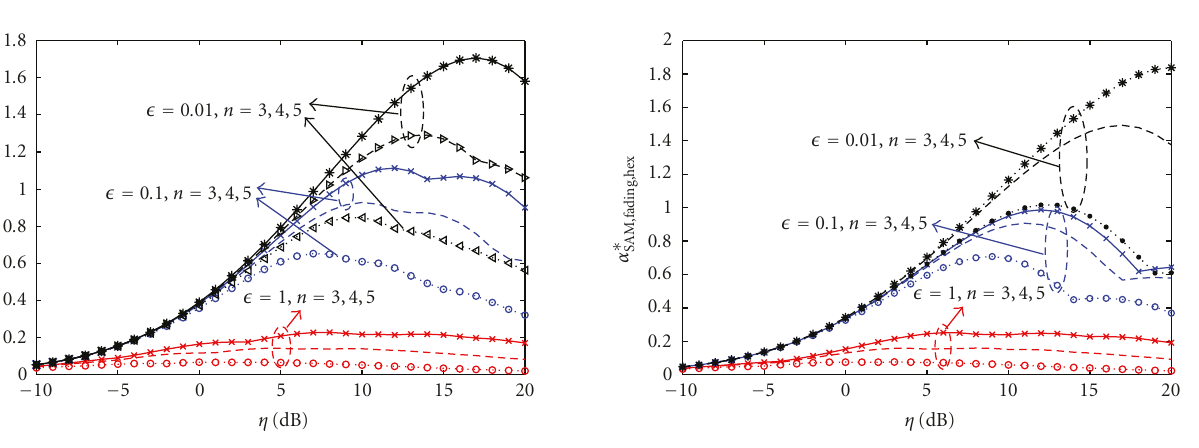
Figure 4: The ( p , q )-optimized α SAM,fading,sq in bits-meters/s/Hz/ node versus η for the square topology under SNR 0 = 30dB and ρ = 1.